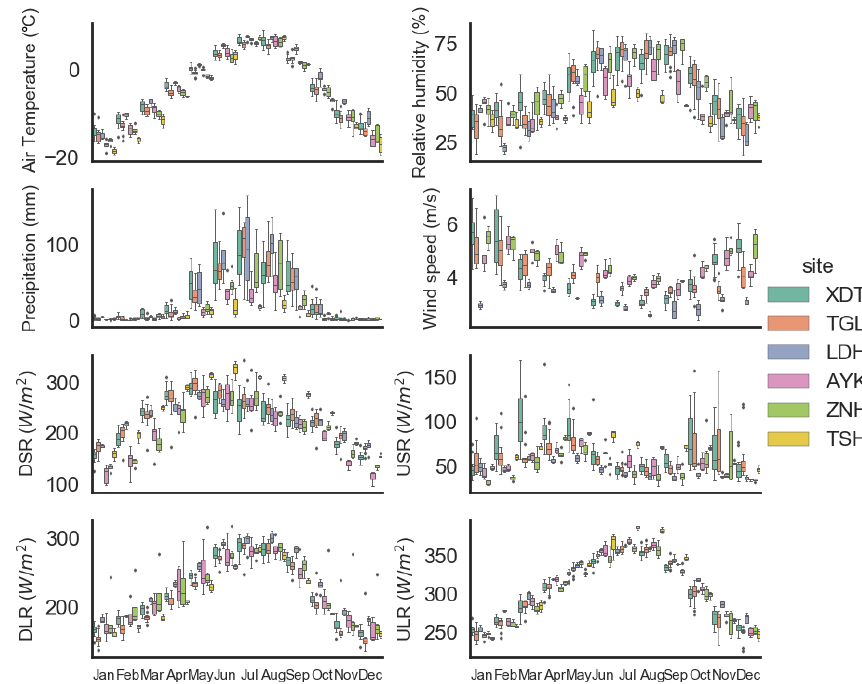
Figure 5. Characteristics of monthly observation variables at six meteorological